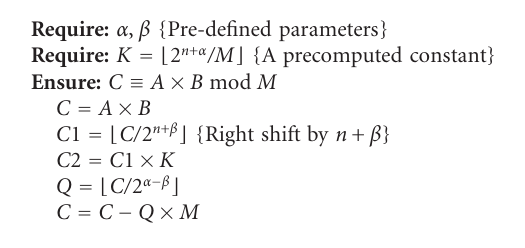
Algorithm 2: Improved Barrett modular